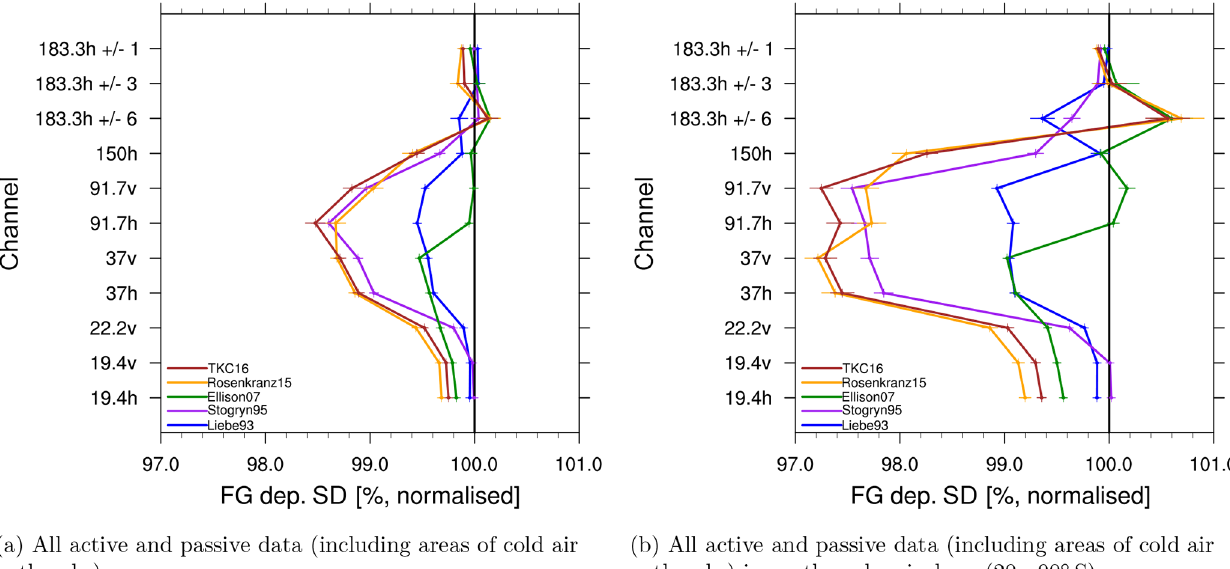
Figure 8. Standard deviation in FG departure from SSMIS-F17 for different channels normalised by the standard deviation of results from Liebe89. The horizontal bars indicate a 95% confidence range. Results cover the time period from 1 to 31 August 2016. Different colours refer to different permittivity models, as shown in the figure.